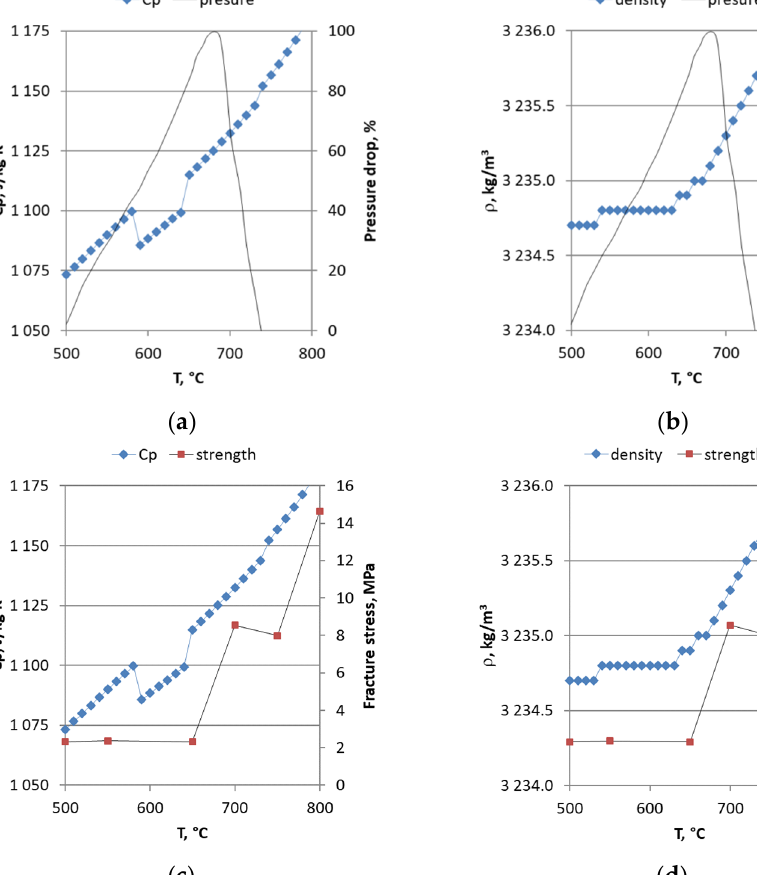
Figure 7. Rye straw: ( a ) Specific heat (c p ) and pressure drop as a function of temperature; ( b ) density ( ρ ) and pressure drop as a function of temperature; ( c ) specific heat and fracture stress as a function of temperature; ( d ) density and fracture stress as a function of temperature.